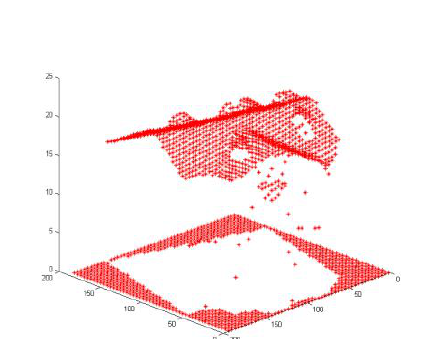
Figure 9: Smoothed point cloud of building roof (GSD 10cm); Dimensions: 200 x 200 pixels